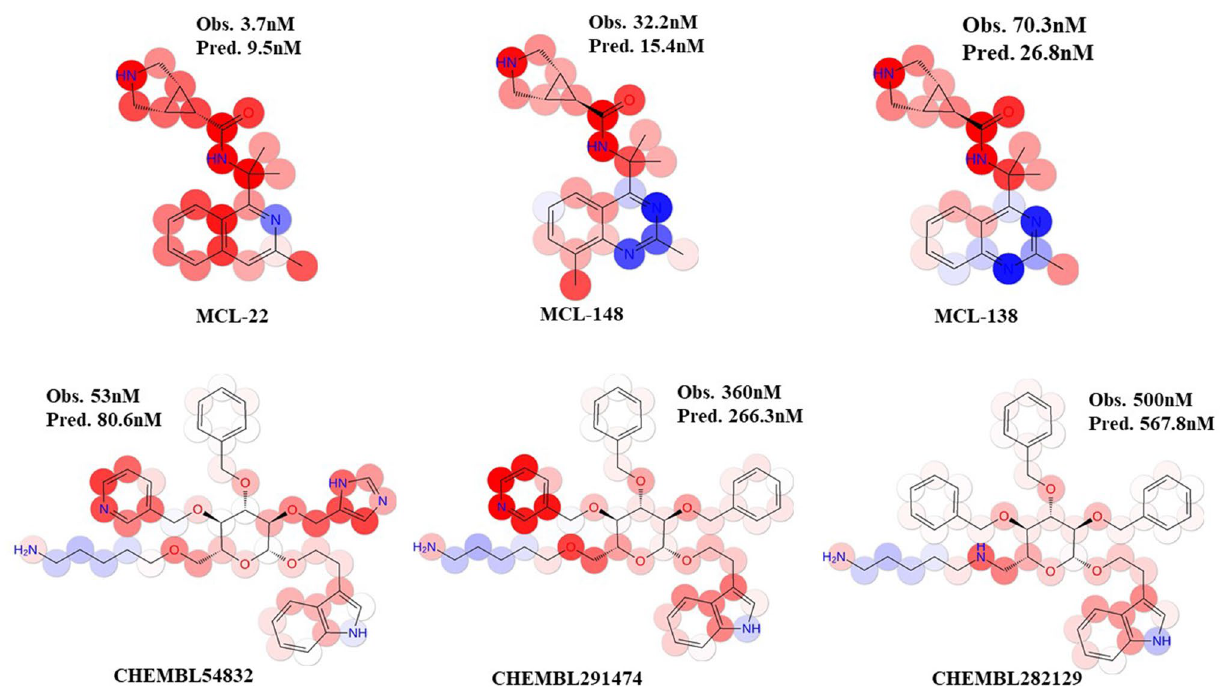
affinity, respectively, while the intensity of the color indicates the strength of that effect. Similarly, visualization of atomic effects on affinity by substitution of the imidazole with a benzene (bottom left to middle compound) or replacement of the pyridine by a ben- zene ring (bottom middle to right) identifies parts of the structures that are more relevant to